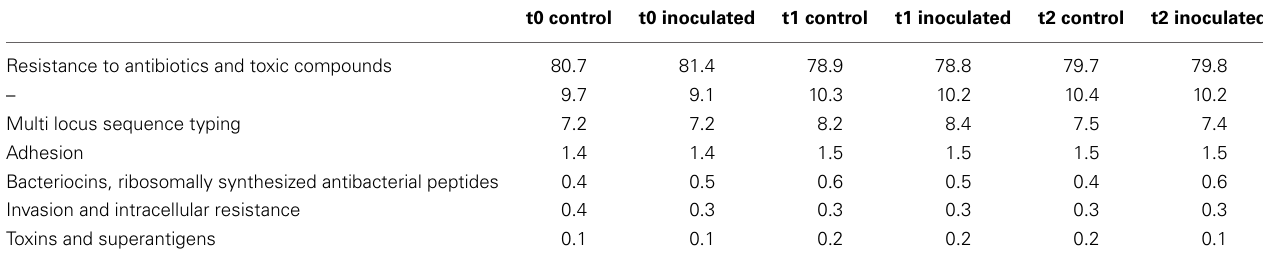
Table 11 | Relative abundances of annotated subsystems within the annotated functional system of Virulence, disease, and